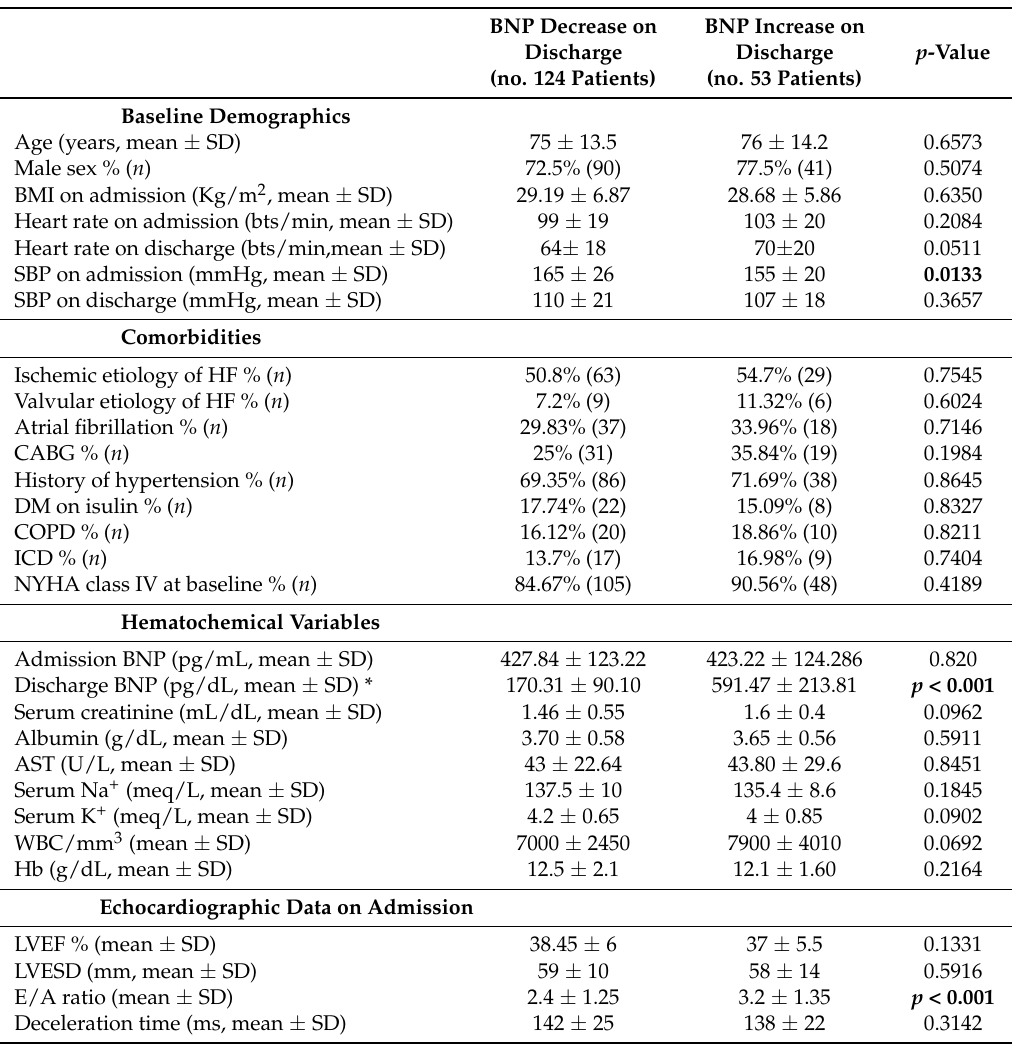
Table 1. Comparison of demographics, clinical, laboratory, and echocardiographic features of patients examined in the retrospective study according to whether or not a patient had a BNP rise on discharge relative to